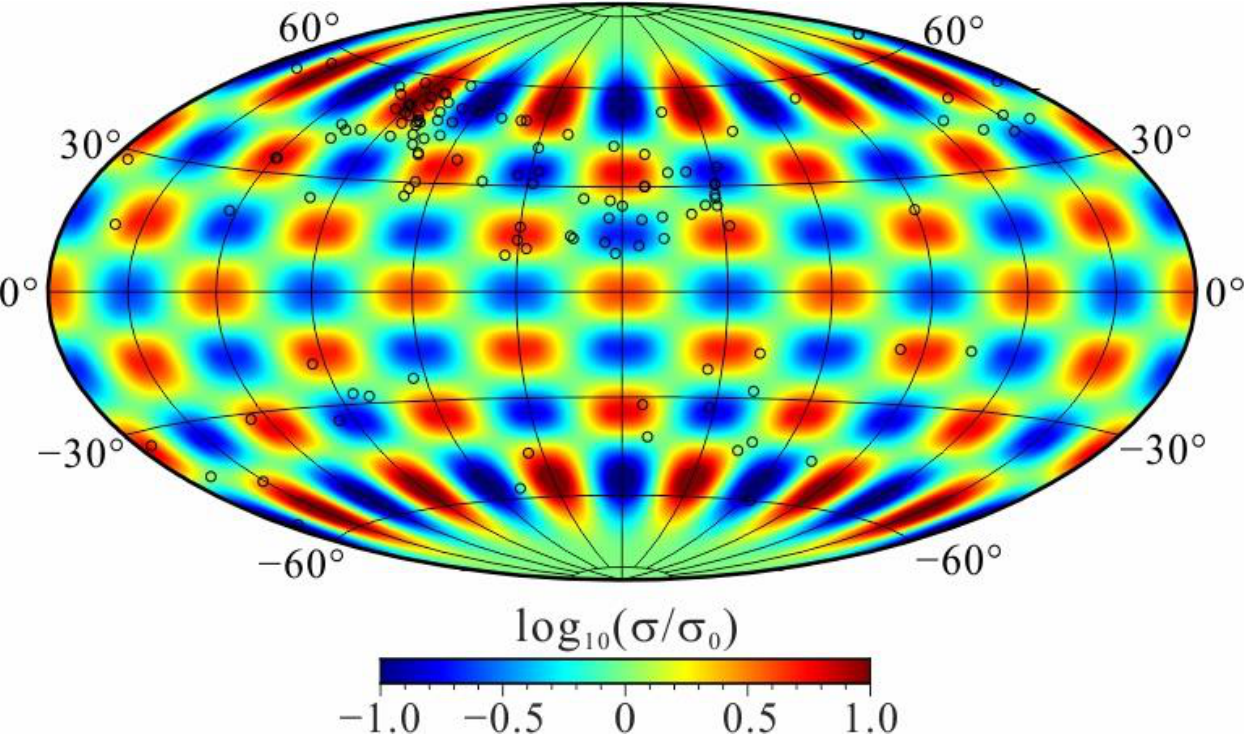
Figure 8. Checkerboard conductivity model and distribution of geomagnetic stations. Anomalies are at depths from 670 to 900 km with the coefficient of the spherical harmonic 𝑎 126 = 2.3 . Open circles indicate the locations of stations in geomagnetic coordinates.